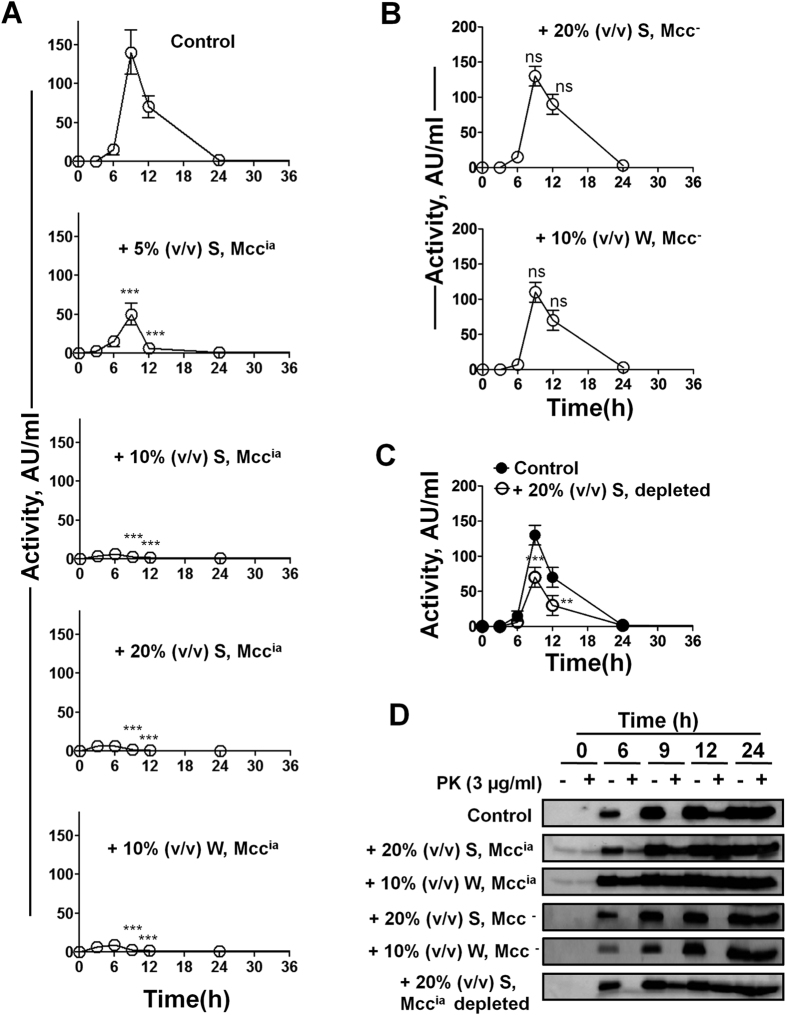
Exogenous addition of Mccia induces the conversion of Mcca into Mccia
in vivo.(A) E. coli VCS257pJEM15 was grown in minimal medium at 37 °C until 36 h either in the absence (control) or in the presence of 5–20% (v/v) culture supernatant (S) or 10% (v/v) whole (W) culture containing Mccia. Aliquots were removed at indicated times and activity of Mcc was measured by CDM. The differences in Mcc activity between control and the various treatments were highly significant (P < 0.0001) in both variables (time and treatment, as well as the interaction between them) as measured by two-way ANOVA. Post-hoc analysis by the Bonferroni test revealed also significant differences between treatment and controls at times 9 and 12 h (***P < 0.001). (B) Mcc producing bacteria were grown in minimal medium in the presence of 20% (v/v) culture supernatant (S) and or 10% (v/v) whole (W) culture of E. coli VCS257 deprived of Mcc plasmid (Mcc-). Activity of Mcc was measured by critical dilution. In this case the differences between control and treatments were not significant as analyzed by two-way ANOVA. (C) Mcc producing bacteria were grown in minimal medium at 37 °C either in the absence (control) or in the presence of 20% (v/v) culture supernatant (S) after immunodepletion using an antibody specific for the sequence of Mcc. Aliquots were removed at indicated times and activity of Mcc was measured by CDM. In this experiment the treatment produced significant differences compared to the untreated control (used the same as panel A, top graph). Individual differences were analyzed by the Bonferroni post-test (*P < 0.05; **P < 0.01; ***P < 0.001). In panels A, B and C, activity was measured in duplicate samples and error bars indicate S.D. D: Immunoblots of aliquots removed from culture used in panels A, B and C before (−) after treatment (+) with PK (3 μg/ml) at indicated time points.